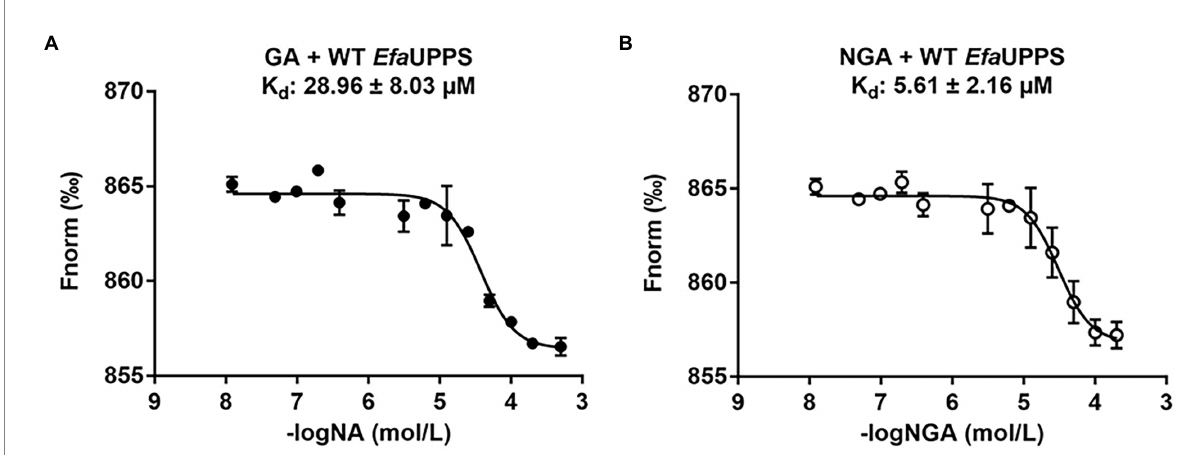
FIGURE 3 MST analyses of the binding of GA (A) and NGA (B) to Efa UPPS. The titration of GA or NGA ranged from 3.05 nM to 200 μ M with a constant concentration of the Efa UPPS at 5 nM. The results of GA were plotted with solid dots, while the results of NGA were plotted with hollow dots. The data are presented as means of three independent biological replicates. Error bars represent mean ± SEM of n = 3